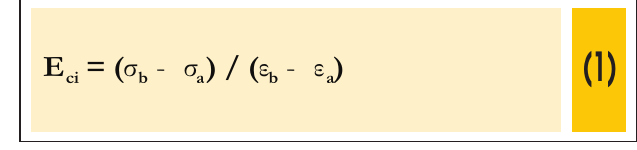
Figure 1 – Different types of modulus of elasticity in the stress-strain